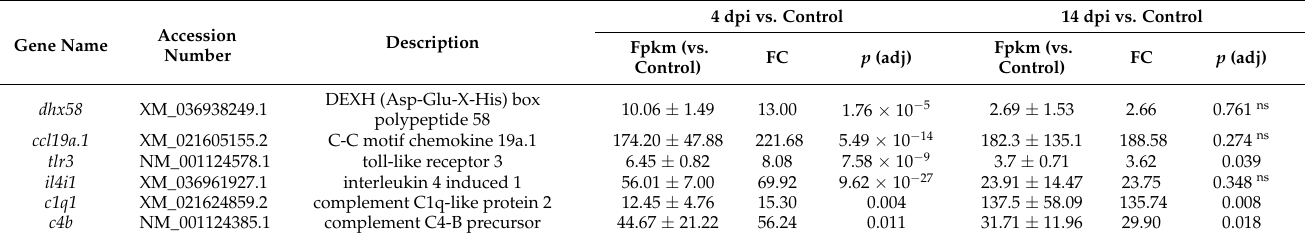
Fpkm (vs. control) represents the expression change of the gene of interest in the infected group relative to the control group, it is expressed as mean ± SEM; FC, fold change; If “ns” is marked at the top right of p (adj), it means that there is no significant difference in the expression of this gene in the corresponding group.